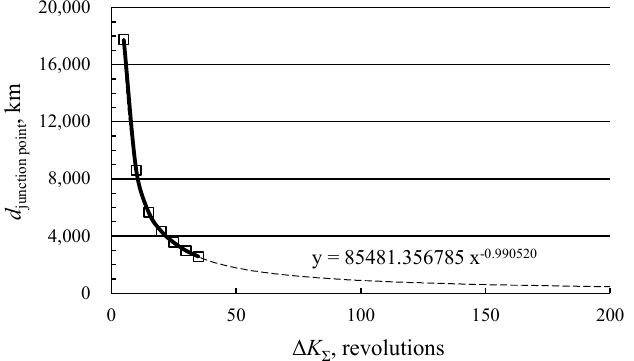
Figure 7. The dependence of distance between the optimal junction point and the libration point EML 1 on the total value of angular variable K in the inertial coordinate system.